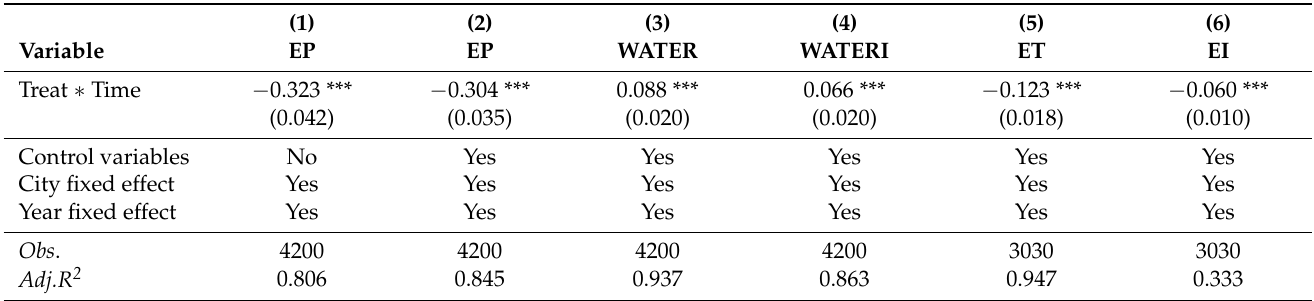
Table 3. Robustness test